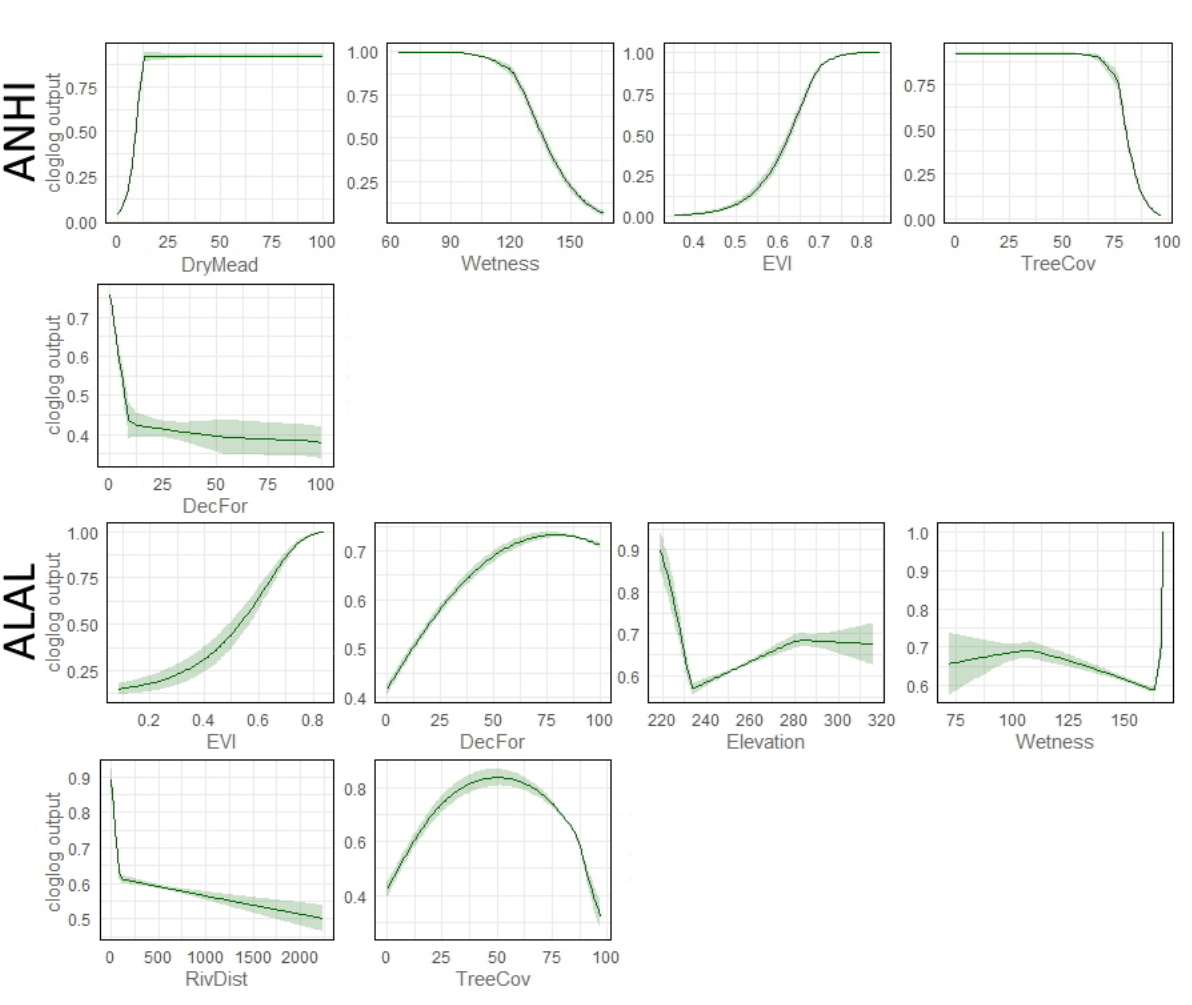
Figure A5. Response curves for the five (insects) and six (mammals) most important variables of the brown bear animal food-probability models in the Central Forest State Nature Reserve and its buffer zone (European Russia) in 2008–2020. Designations: ANHI—anthills, ALAL— Alces alces . The curves show the mean response of the ten cross-validation MaxEnt runs and the mean ± one standard deviation. EVI—enhanced vegetation index; Wetness—tasseled cap wetness; Elevation—elevation (m a.s.l.); RivDist—distance to rivers; DecFor—proportion of deciduous forests (mixed small-leaved forests) (%); YoungFor—proportion of young forests and overgrown clearings (%); DryMead—proportion of dry meadows (%); TreeCov—forest canopy cover. Units of the variables are shown in Table 1 of the main text.